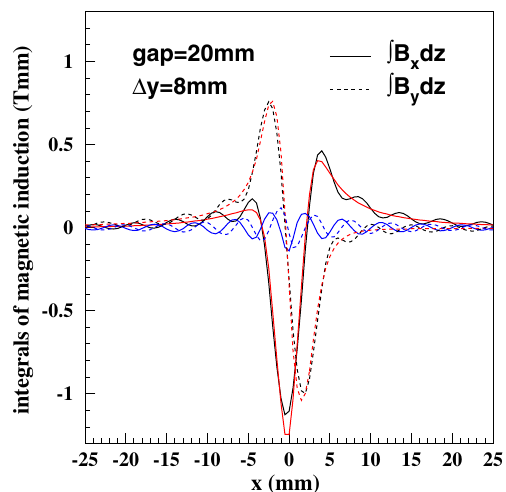
FIG. 10. Off plane accuracy of the L -shim field integrals in the inclined mode. The data are evaluated for a standard L -shim quadruple (see text) of the UE112 8 mm above the midplane with gap ¼ 20 mm , shift ¼ 0 : 25 (cid:3) 0 . Black: Exact values as evaluated with RADIA . Red: Analytic model with 80 Fourier coefficients. The expansion ranges goes from (cid:1) 200 mm to þ 200 mm with a spacing of 0.5 mm. Blue: